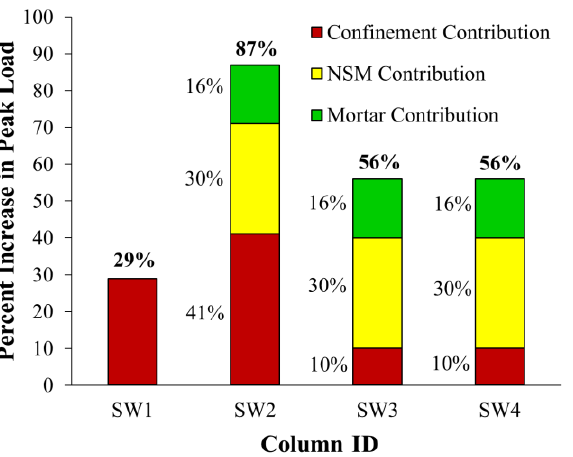
Figure 25. Comparison of strengthened columns with respect to percent enhancement in maximum load (based on FE results).